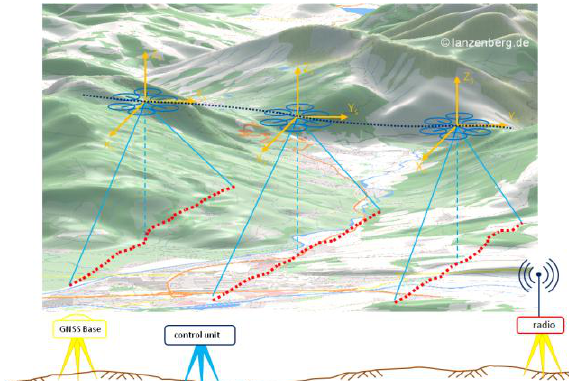
Figure 3. Measurement process with base station and remote control unit